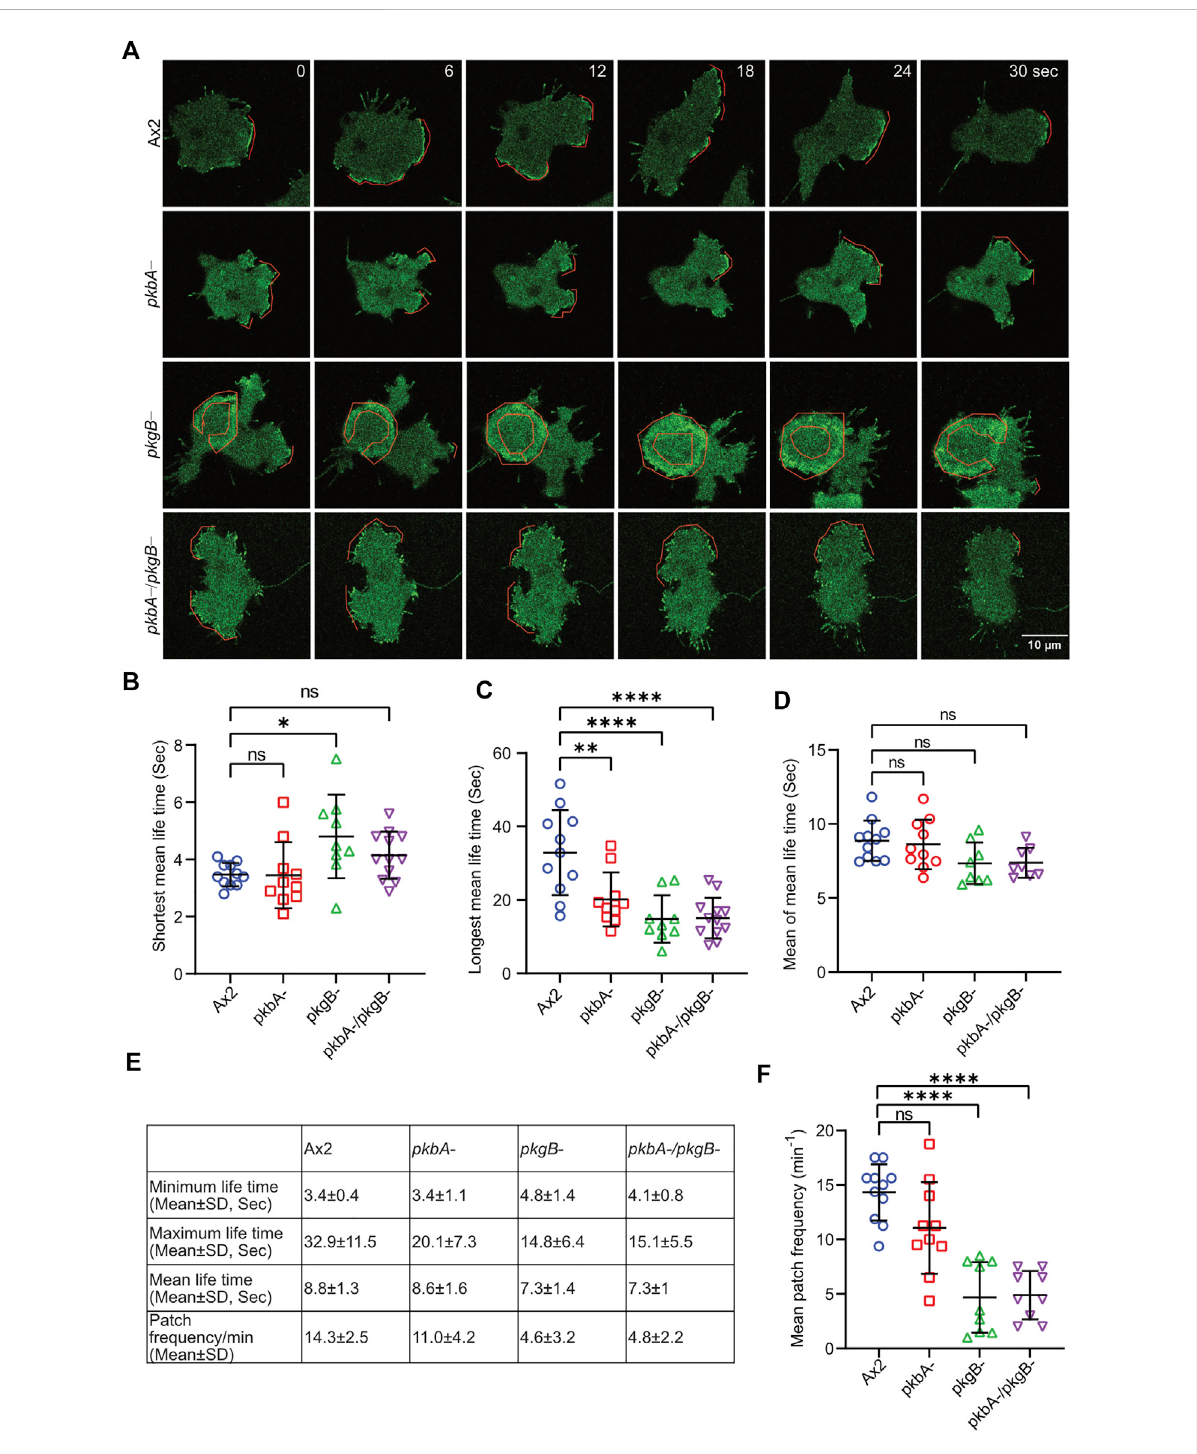
FIGURE 5 The recruitment of the Scar/WAVE complex in Ax2 and mutant cells. Subcellular localization of the Scar/WAVE complex in protrusions. (A) Ax2, pkbA -, pkgB - and pkbA-/pkgB - cells were labelled with HSPC300-eGFP (Scar/WAVE complex) and allowed to migrate under agarose following a folate gradient and imaged by AiryScan confocal microscopy at a frame interval of 3 s (1f/3 s). The Scar/WAVE complex is localized to protrusions of pseudopodia of all cell types (dotted line). (B – D) Quanti fi cation of lifetime to Scar/WAVE recruitment. The lifetime of the Scar/WAVE complex accumulation was quanti fi ed using homemade ImageJ plugin. Mean lifetimes of shortest (B) , longest (C) and mean (D) Scar/WAVE duration were plotted. ( n > 9 cells over three experiments, mean ± SD, ns = non-signi fi cant * p ≤ 0.05, ** p ≤ 0.01, *** p ≤ 0.001, One-way ANOVA, Dunn ’ s multiple comparison test). (E) Scar/WAVE lifetimes in protrusions of cell lines. (F) Scar/WAVE recruitment frequency in the protrusions of